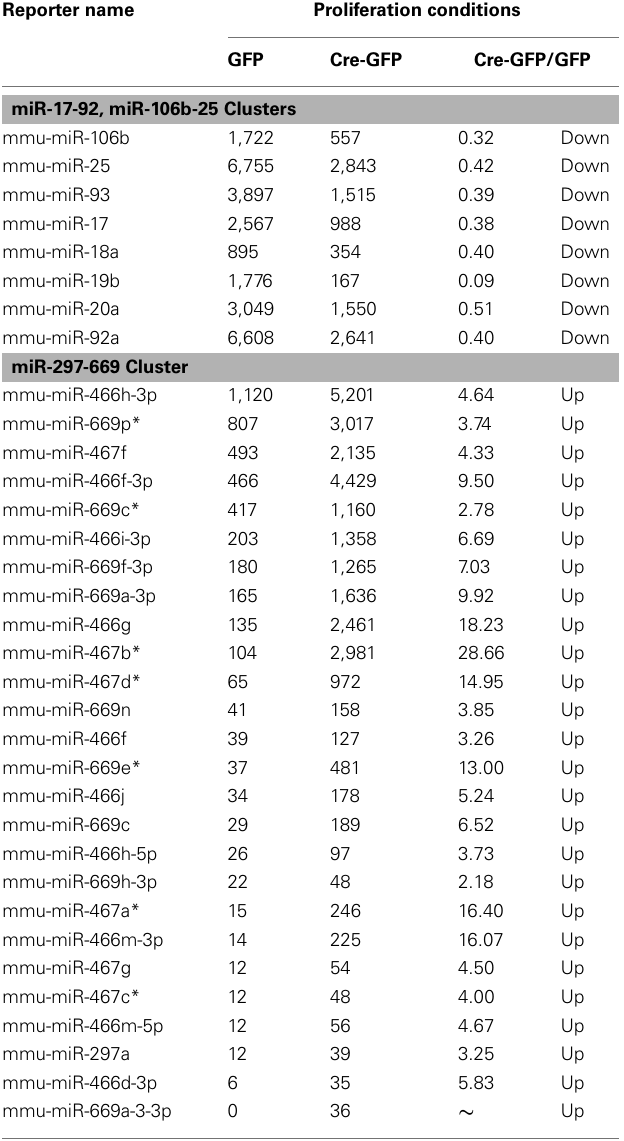
TableA2 | MiRNAs from the same genomic loci have similar expression dynamics.